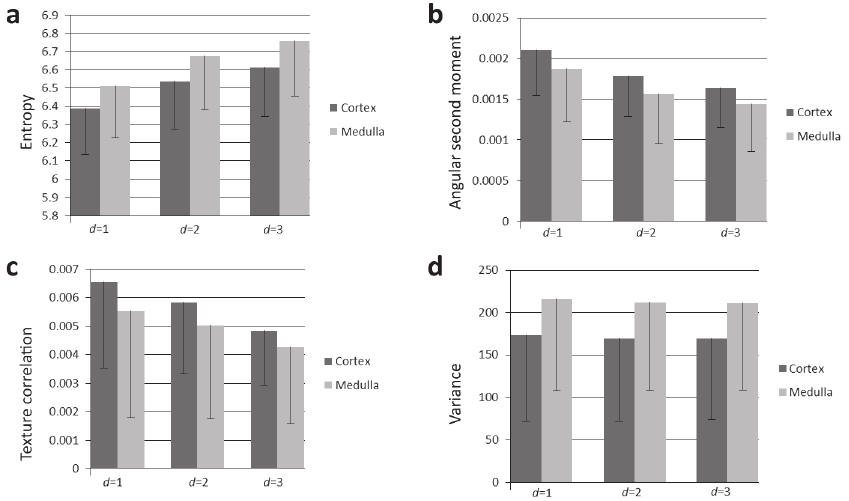
Figure 2 - GLCM entropy (a) , angular second moment (b) , correlation (c) and variance (d) of thymus cortical and medullar lymphocyte